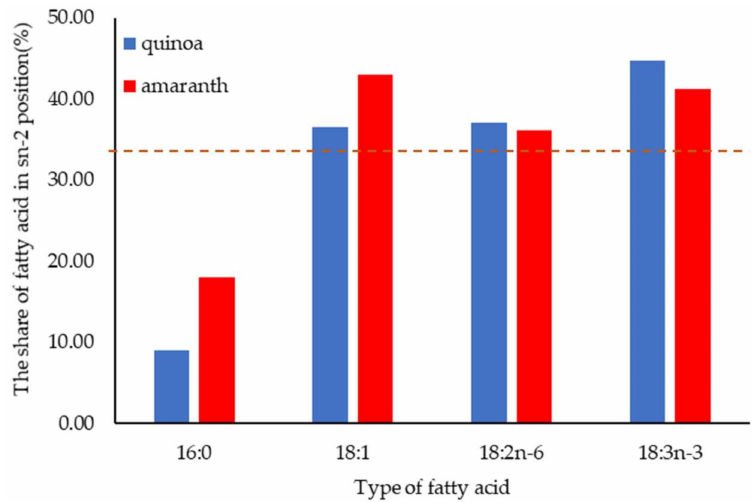
Figure 2. The percentage of palmitic, oleic, linoleic and α -linolenic acids in the sn-2 position of triacylglycerols (TAG) of amaranth and quinoa